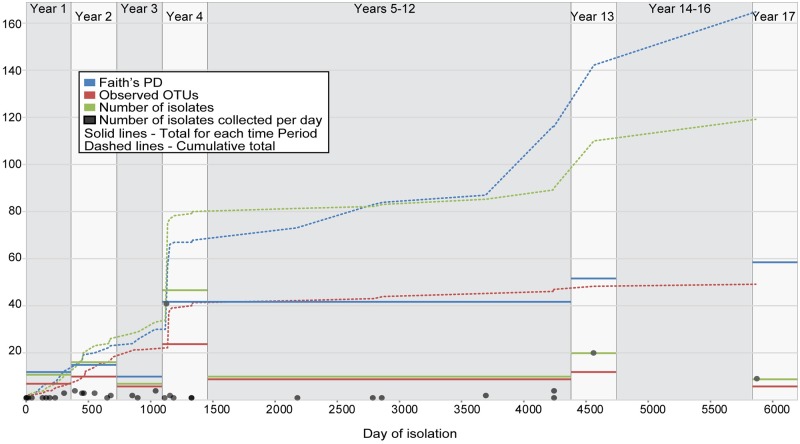
Population diversity dynamics.Estimates of diversity (Faith’s PD and Observed OTUs) in each time period and accumulating over time. This shows that mutations in the first part of year 1 cause a rapid increase in accumulated diversity that continues with time. Continued extinction of earlier genotypes suppresses this accumulation of diversity at each time period. This changes in year 4 when diversity in this time period dramatically increases and, despite the extinction of most newly emerged lineages, is maintained thereafter due to the persistence and continued divergence of two clades. The number of observed OTUs and isolates in each time period remains mostly constant with the exception of year 4 due to the large number of isolates collected from the lobectomy.